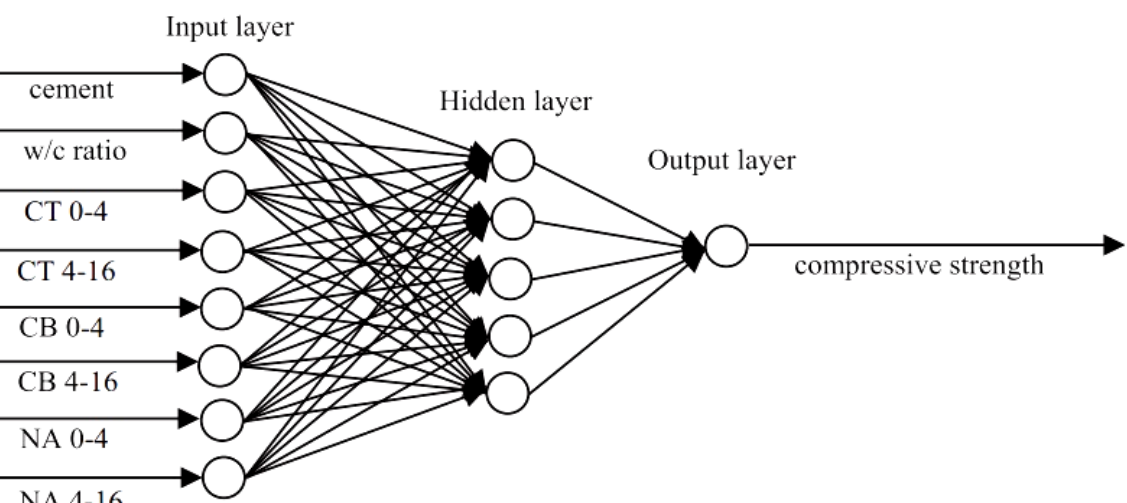
Fig. 4. Structure of Artificial Neural Network, consisting of 8 input parameters, one output parameter, one input layer, one hidden layer, and one output